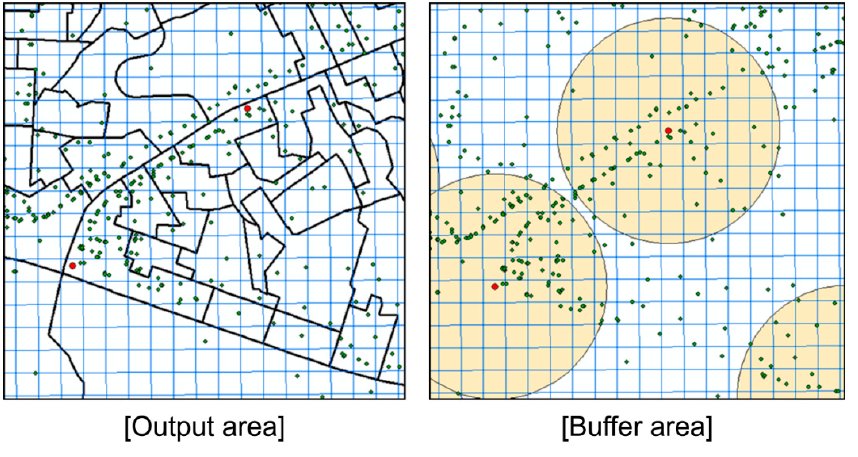
Figure 4. Standardization of different space units into mesh data.